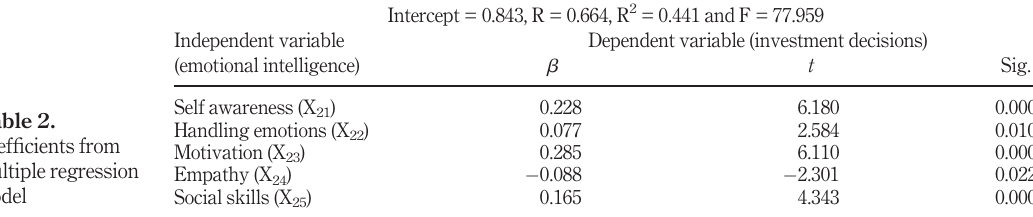
Table 2. Coef fi cients from multiple regression